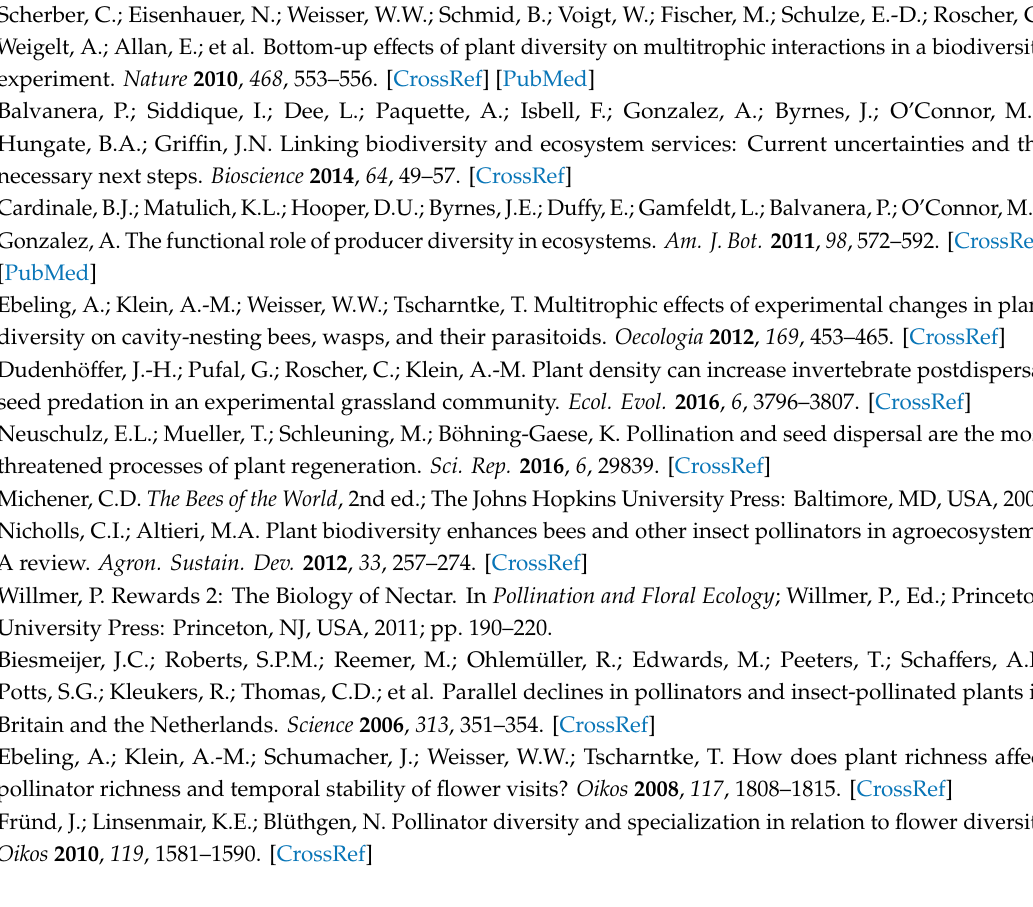
Figure S1: Map displaying sizes and locations of plots sampled in this experiment (modified after [48]). Table S1: List of plant species communities with one, four, eight, and 16 plant species, providing plot IDs, sampling year, and sucrose concentration (%) as measured for one sample with a hand-held refractometer, and the numbers and actual species of other plant species flowering and not flowering when Knautia arvensis was flowering in 2011. Table S2: List of individual flower visitors to all Knautia arvensis in plant species communities with eight and 16 plant species observed in 2011. Figure S2: List of figures presenting the mean ( ± SD) concentrations and proportions of individual amino acids and carbohydrates as well as total amino acids (AA), all essential amino acids (EAA), and all non-essential amino acids (nEAA) as found in floral nectar of Knautia arvensis from di ff erent plant species mixtures (i.e., monoculture, four, eight, and 16 plant species